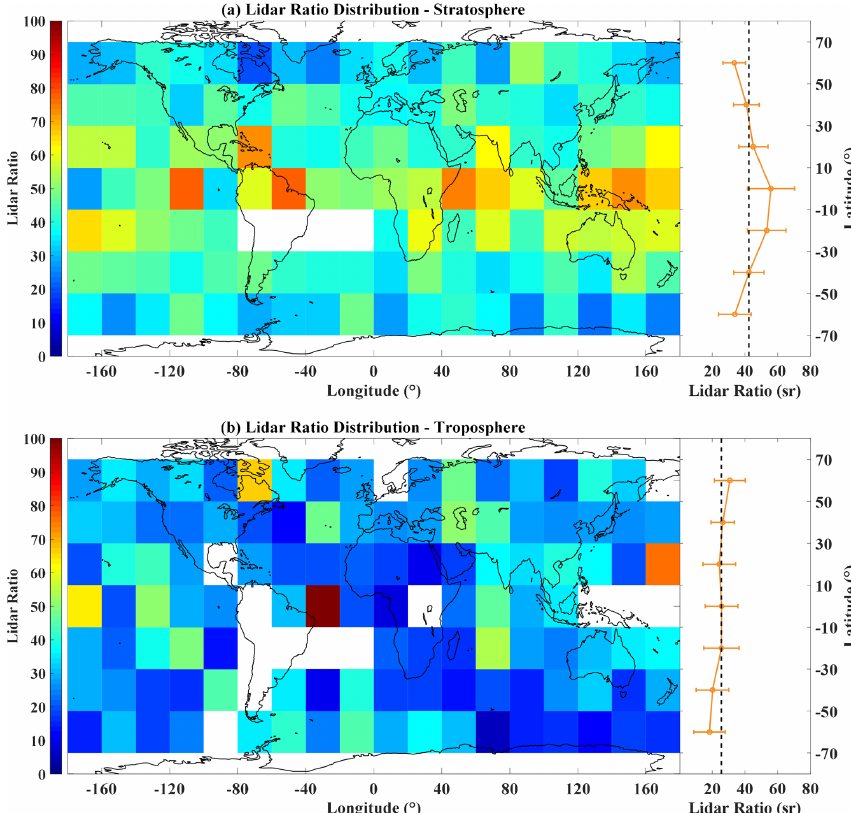
Figure 3. (a) Global stratospheric distribution of lidar ratios with a grid size of 20 ◦ × 20 ◦ . The colour bar represents the median lidar ratio value. The line on the right shows the median variation at 20 ◦ intervals from − 70 ◦ to 70 ◦ (latitude) globally, and the error bar represents the median absolute deviation. Panel (b) is the same as panel (a) , but for the troposphere. A blank grid indicates that no data is available.